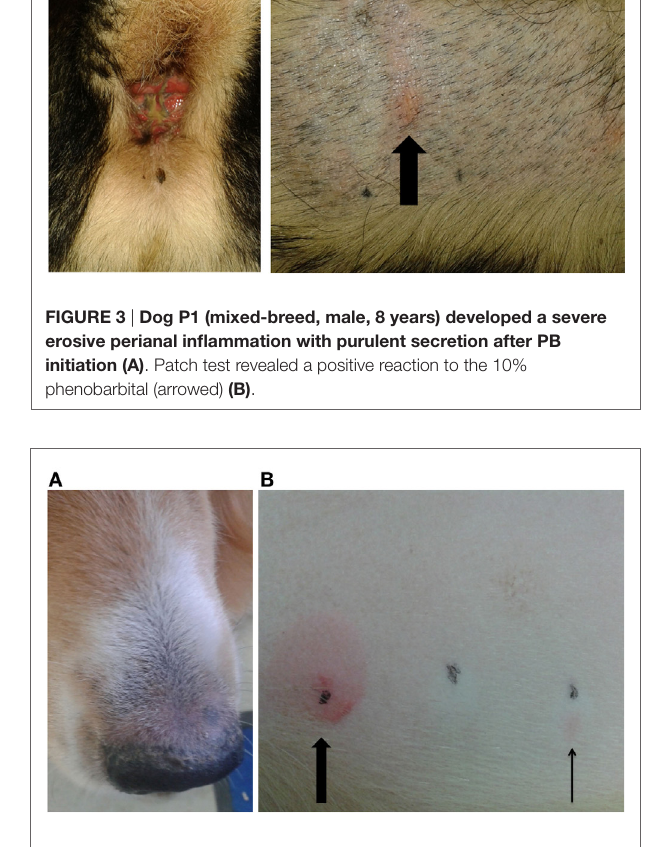
FigUre 4 | Dog P3 (mixed-breed, male, 4 years) developed pruritus and crusty lesions at the hind limbs and the rhinarium (a) . Intradermal test revealed a positive reaction at the phenobarbital injection site (slim arrow), compared to positive control (big arrow) (B) .